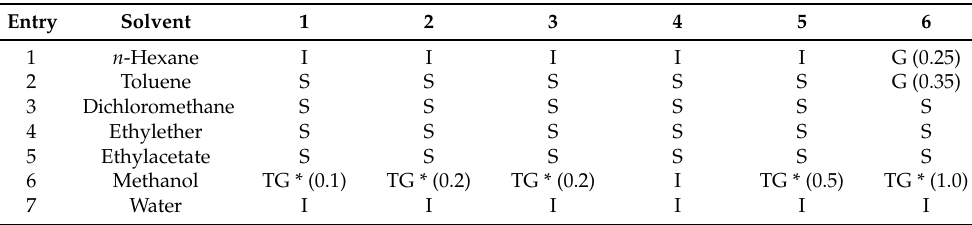
Table 1. Gelation tests of triphenylene derivatives 1 – 6 .